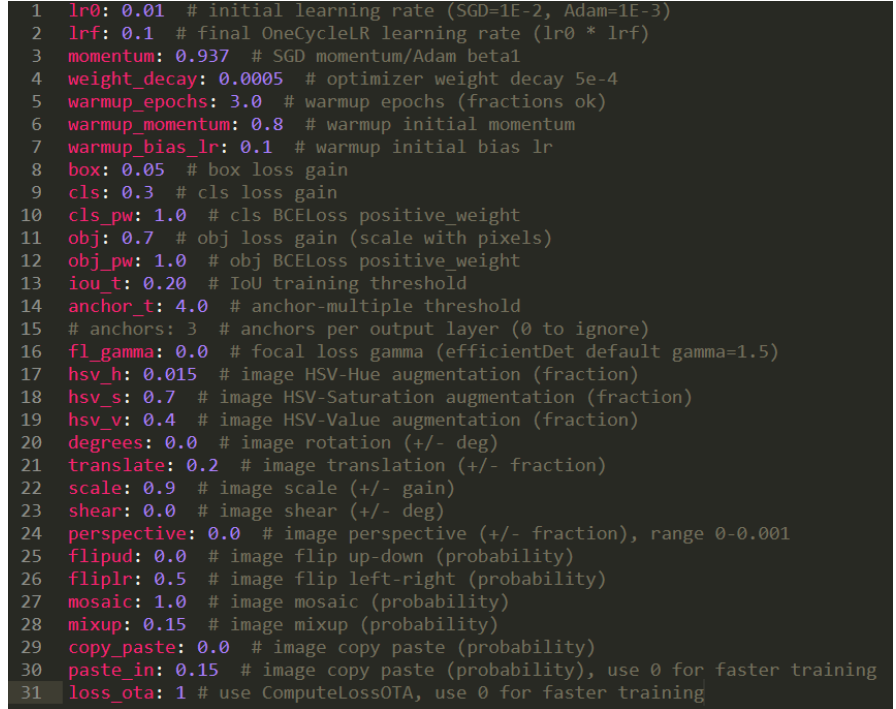
Figure 18. Illustrating the hyper-parameters of YOLO-family